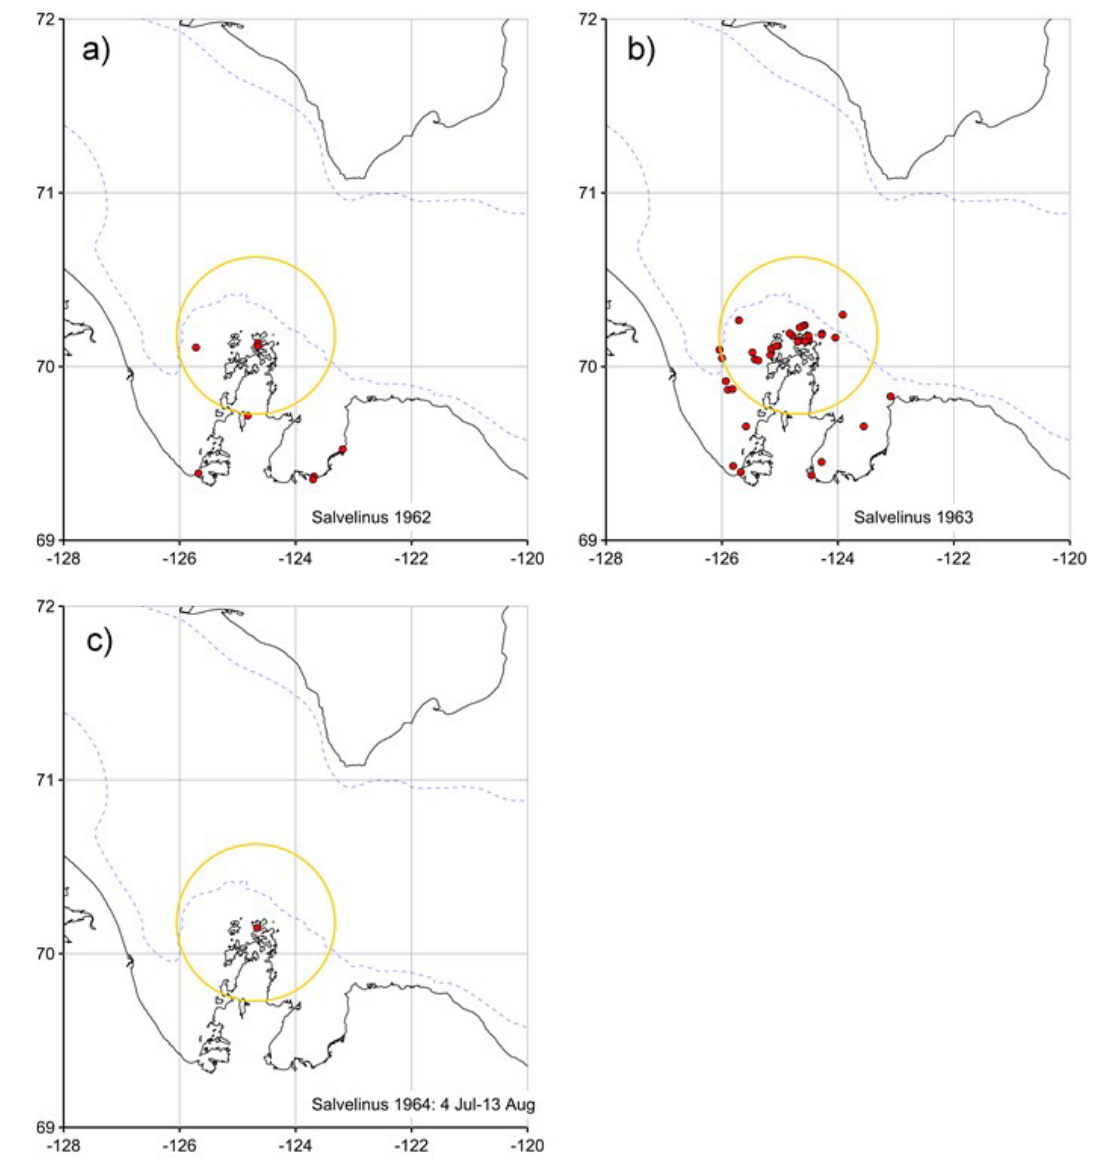
Figure 4. Locations of water profile surveys conducted near the ANMPA by the M/V Salvelinus in a) 1962, b) 1963, and c) 1964. Surveys collected temperature, salinity, and occasionally dissolved oxygen data (Hunter and Leach 1983). Maps provided by H.